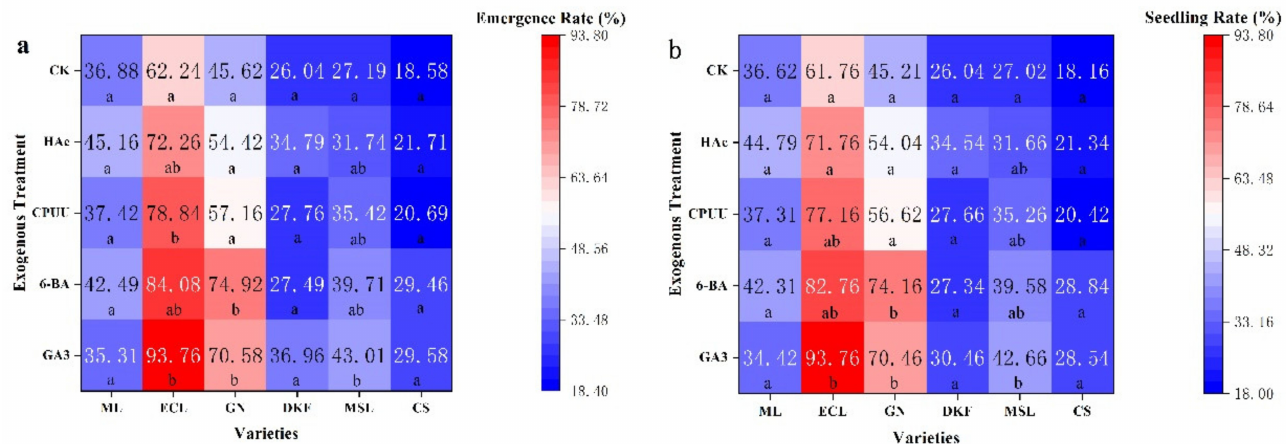
Figure 6. Effect of chemical treatments on seed seedling characteristics of six tested varieties: ( a ) effect of chemical treatments on seedling rate of tested varieties, and ( b ) effect of chemical treat- ments on seed seedling rate in tested varieties. Data in this figure were tested by One-way ANOVA; means followed by the same letter in column do not differ according to Tuker’s test ( p ≤ 0.05). ML, ECL, GN, DKF, MSL, and CS represent varieties of Meili, Ecolly, Garanior, Dunkelfelder, Marselan, and Cabernet